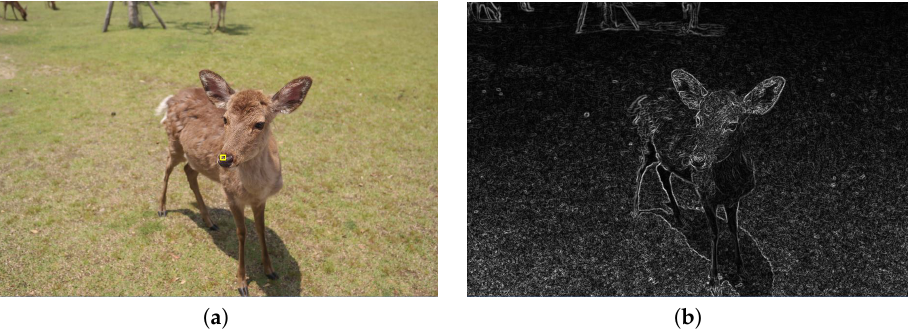
Figure 17. ( a ) Original image. ( b ) Edge detection result.